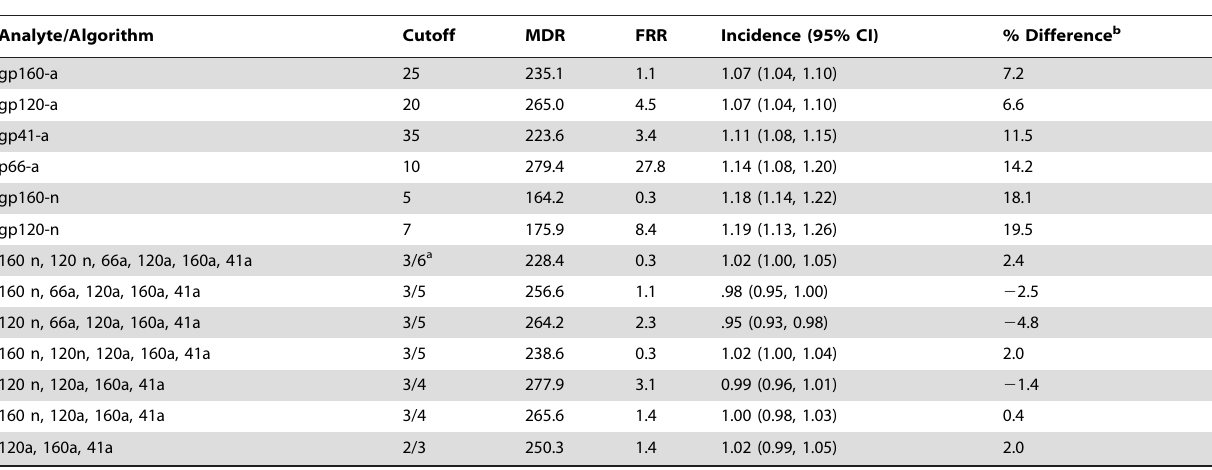
Table 1. Characterization of the HIV-1-specific Bio-Plex.